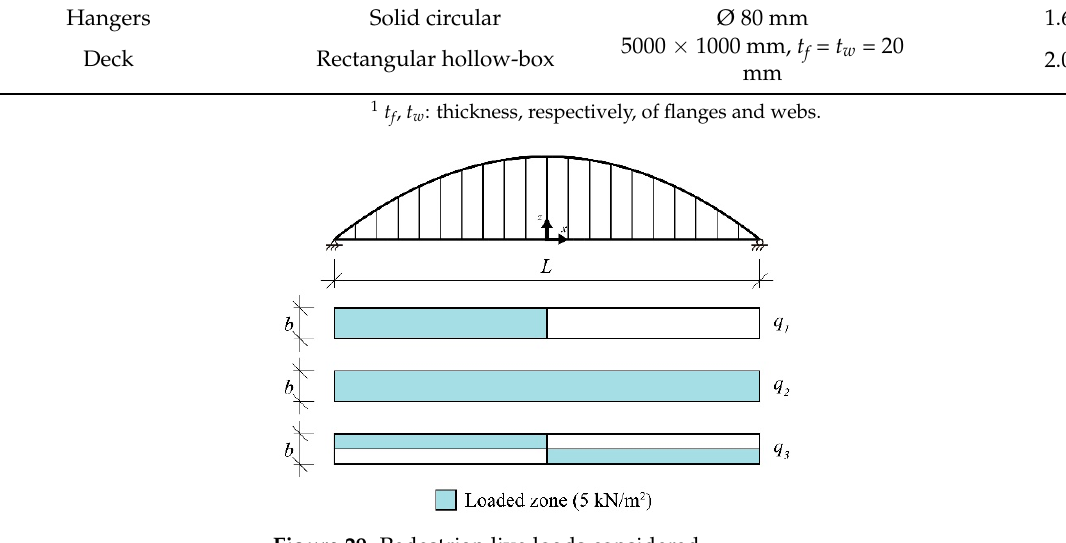
Figure 29. Pedestrian live loads considered.